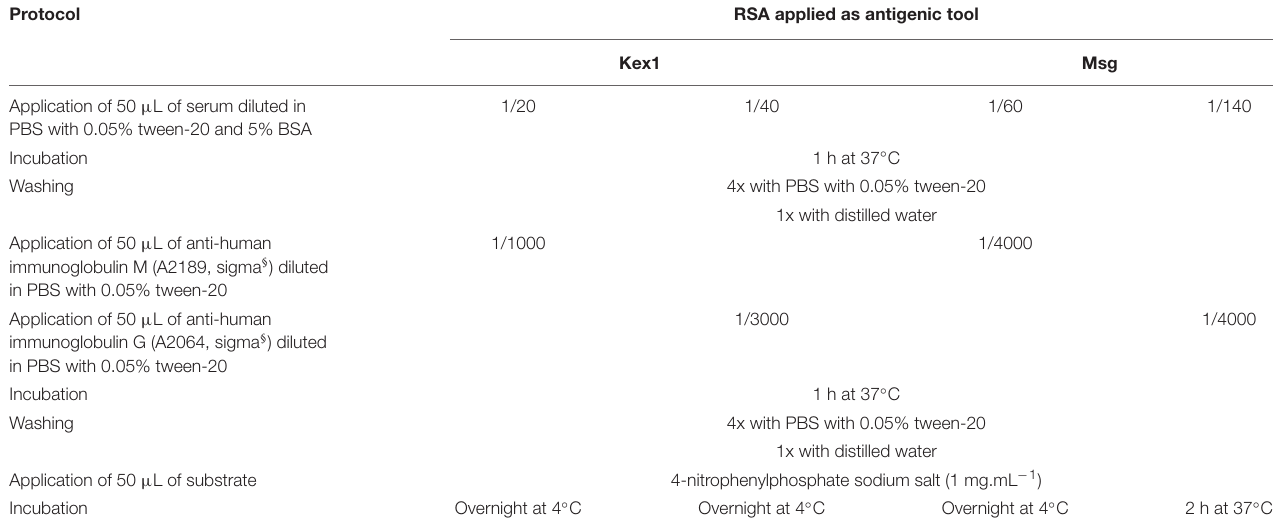
TABLE 1 | ELISA protocols and conditions for detection of IgG and IgM anti- P. jirovecii antibodies reactive against the RSA produced. Protocol RSA applied as antigenic